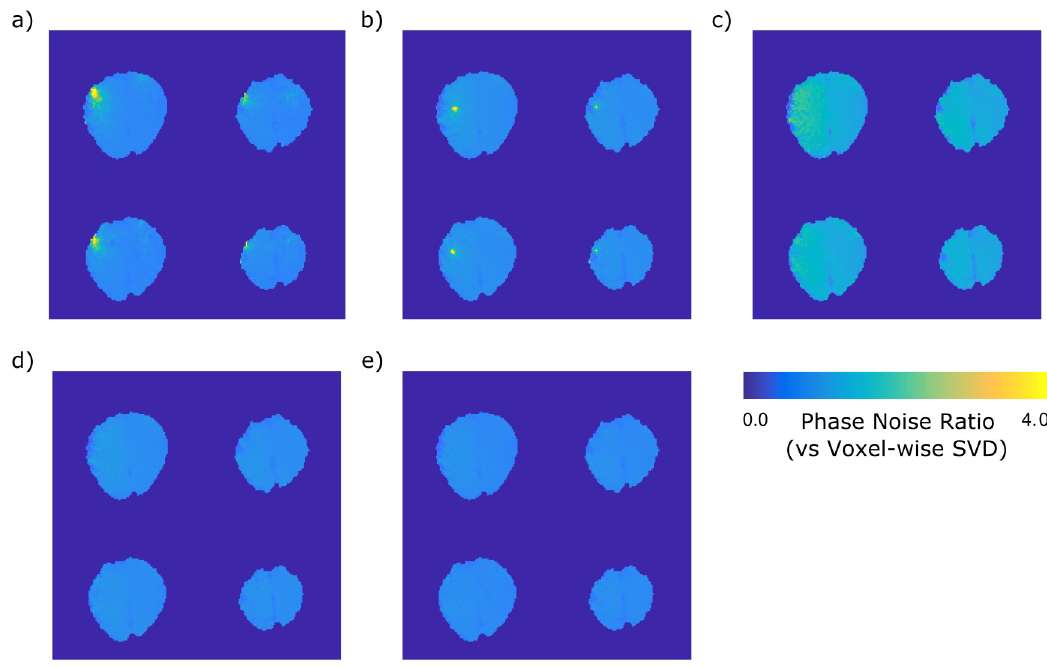
Fig 5. Phase noise ratios in an asymmetrical coil. Voxel-wise SVD was used as the reference method. Phase noise ratio combined using a) complex sum, b) VRC, c) BCC, d) the fitted SVD method using the B1+ prescan, and e) the fitted SVD method using the EPI timeseries as input. Hyperintensities correspond with phase singularities in a and